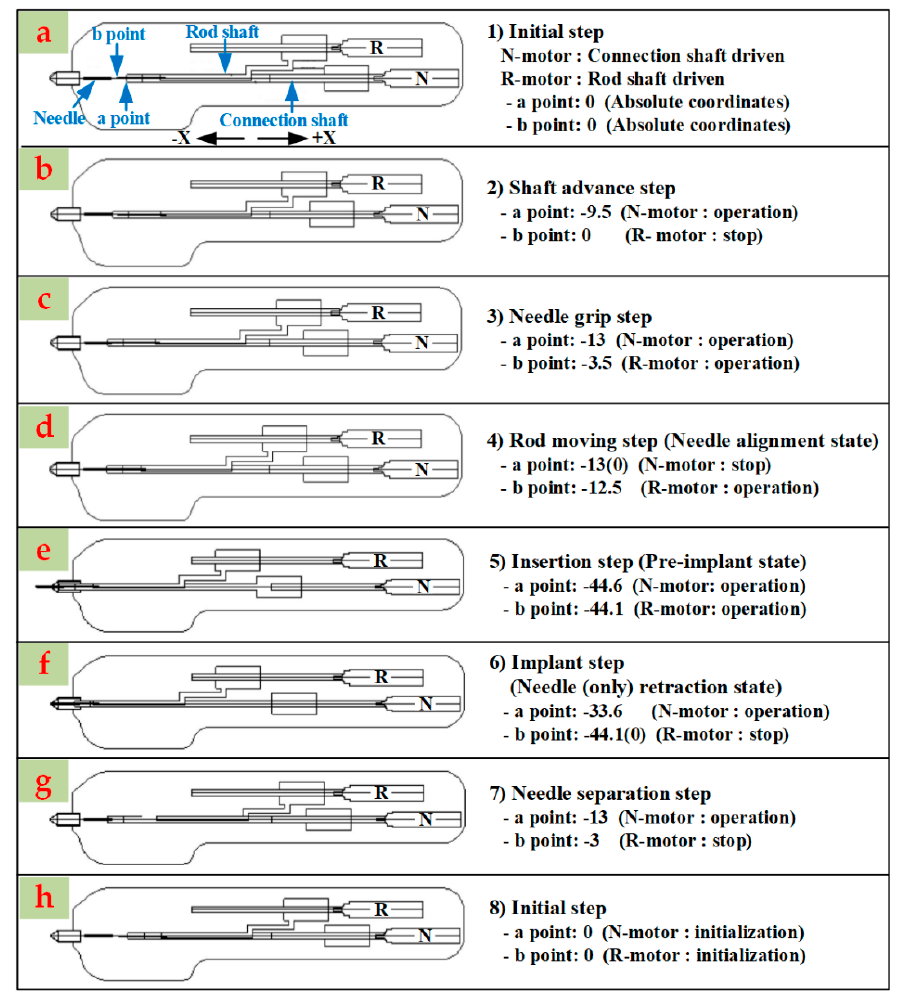
Figure 9. Operation sequence of the needle and the rod. ( a ) Initial step, ( b ) shaft advance step, ( c ) needle grip step, ( d ) rod moving step, ( e ) insertion step, ( f ) implant step, ( g ) needle separation step, and ( h ) initial step.